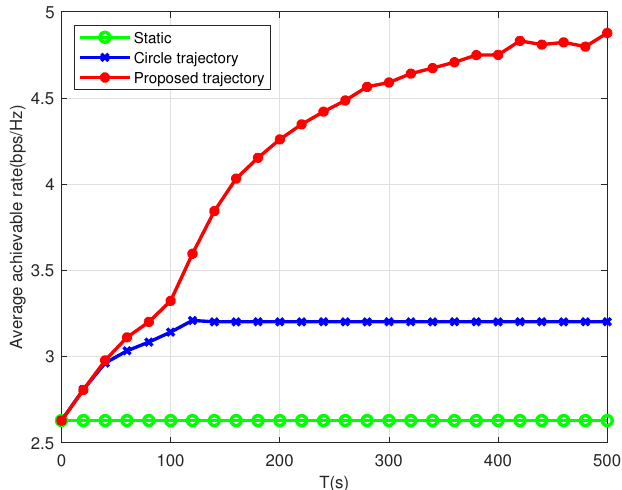
Figure 4. The average achievable rate for the single-UAV scenario versus T with different trajectory designs.